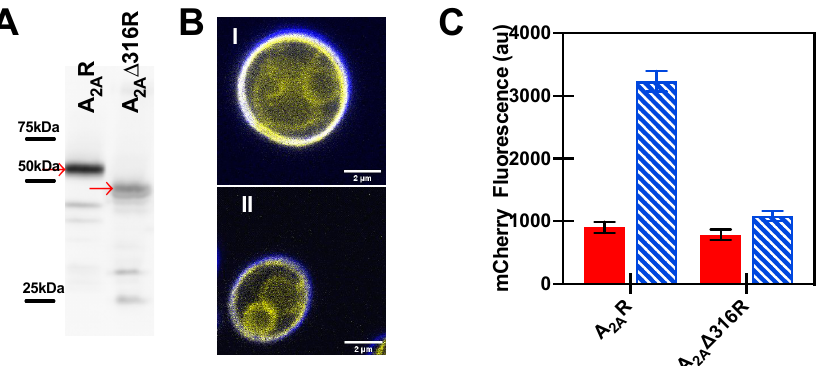
Figure 3. Truncation of the C-terminus for A 2A R (A 2A ∆ 316R) resulted in a loss of the signaling response in yeast strains. ( A ) Full-length expression of mCitrine tagged wild-type and truncated A 2A R was observed using Western blot analysis with an anti-GFP antibody. Full-length receptor is indicated by an arrow. Molecular weights were estimated using Precision Plus Protein Western C standards. The expected molecular weight of each receptor is as follows: A 2A R, 71.6 kDa; and A 2A ∆ 316R, 66.1 kDa. Note that the mobilities are slightly faster than that expected by calculated molecular weight; membrane proteins have been found to run faster than expected, possibly due to their hydrophobicity or incomplete denaturation, due to the absence of sample heating [88]. ( B ) Representative confocal images of yeast cells expressing (i) A 2A R and (ii) A 2A ∆ 316R show plasma membrane localization of the receptor. Scale bar = 2 µ m. Images performed as described in Experimental Section. ( C ) MAP kinase response signaling of the full length A 2A R and truncated (A 2A ∆ 316R) receptor in Gpa1p-G α s engineered strain. NECA (100 µ M) shown as blue hatched bars and DMSO control as red filled bars. Data represents the mean ± 95% C.I. for experiments performed in duplicate for three independent